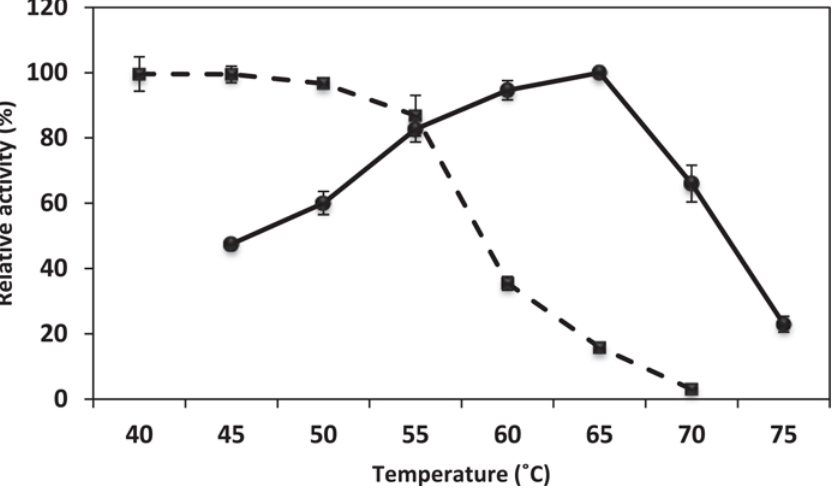
Fig 3. Effect of temperature on HZ lipase activity and stability. ● Temperature-activity curve: results are expressed as a percentage of the maximal activity. ■ Temperature-stability curve: results are expressed as a percentage of the residual activity. SD is indicated as error bars. When the error bar cannot be seen, the deviation is less than the size of the